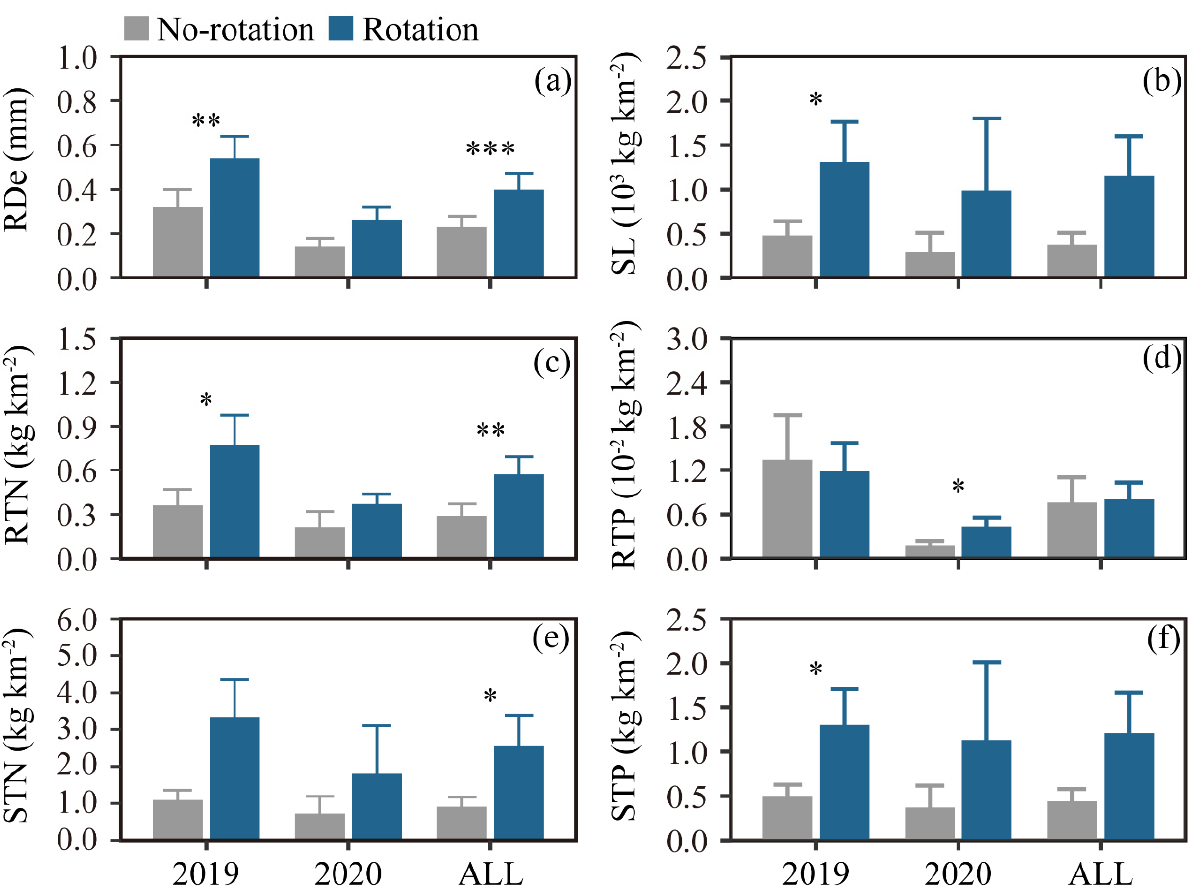
Figure 3. The ( a ) runoff depth (RDe), ( b ) soil loss (SL), ( c ) total nitrogen in runoff (RTN), ( d ) total phosphorus in runoff (RTP), ( e ) total nitrogen in soil loss (STN), and ( f ) total phosphorus in soil loss (STP) in rotation and no-rotation systems for 2019 and 2020. ALL: both years (2019 and 2020); *, p < 0.05; **, p < 0.01; *** p <